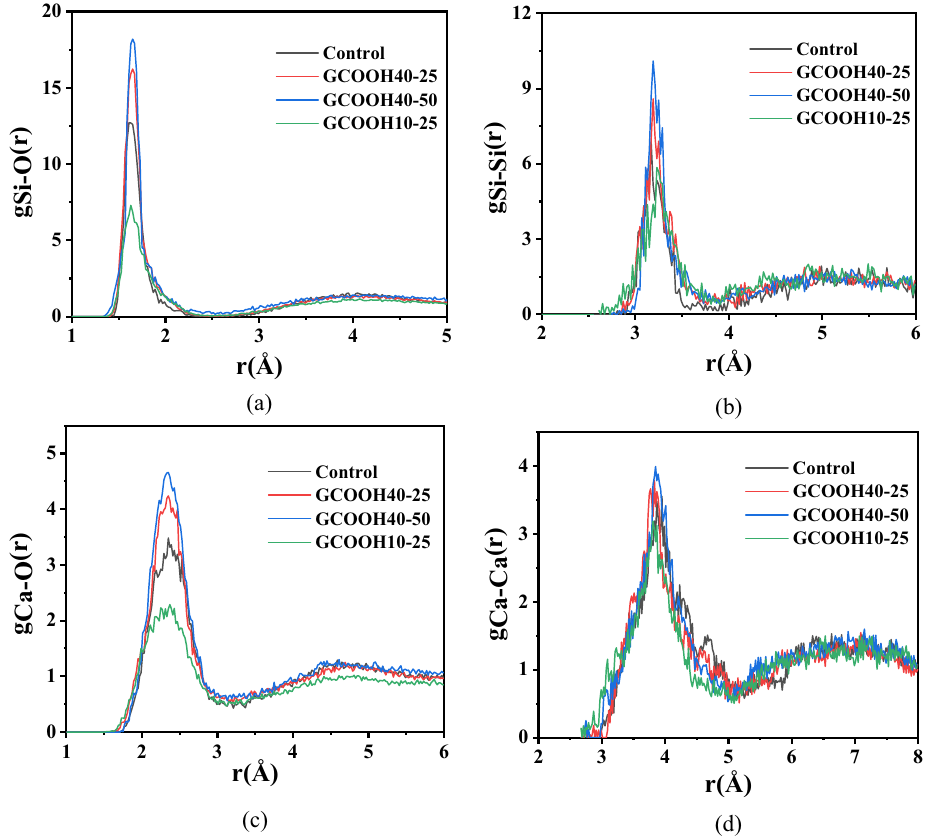
Figure 7: Atomic radial distribution function. ( a ) Si – O, ( b ) Si – Si, ( c ) Ca – O, and ( d ) Ca –